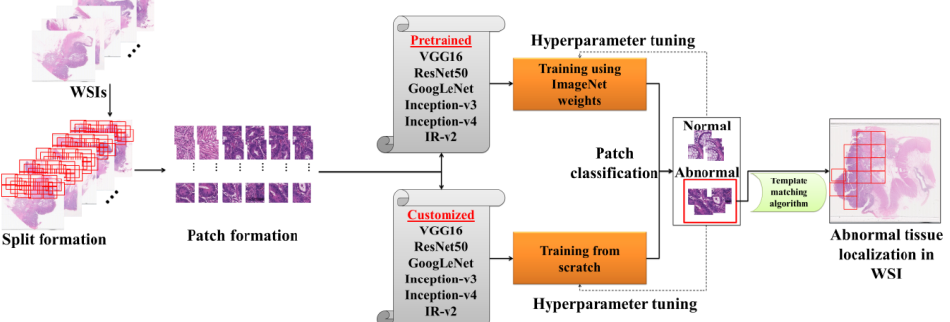
Figure 5. Illustration of the proposed work for classification and localization of abnormal tissues in WSI.